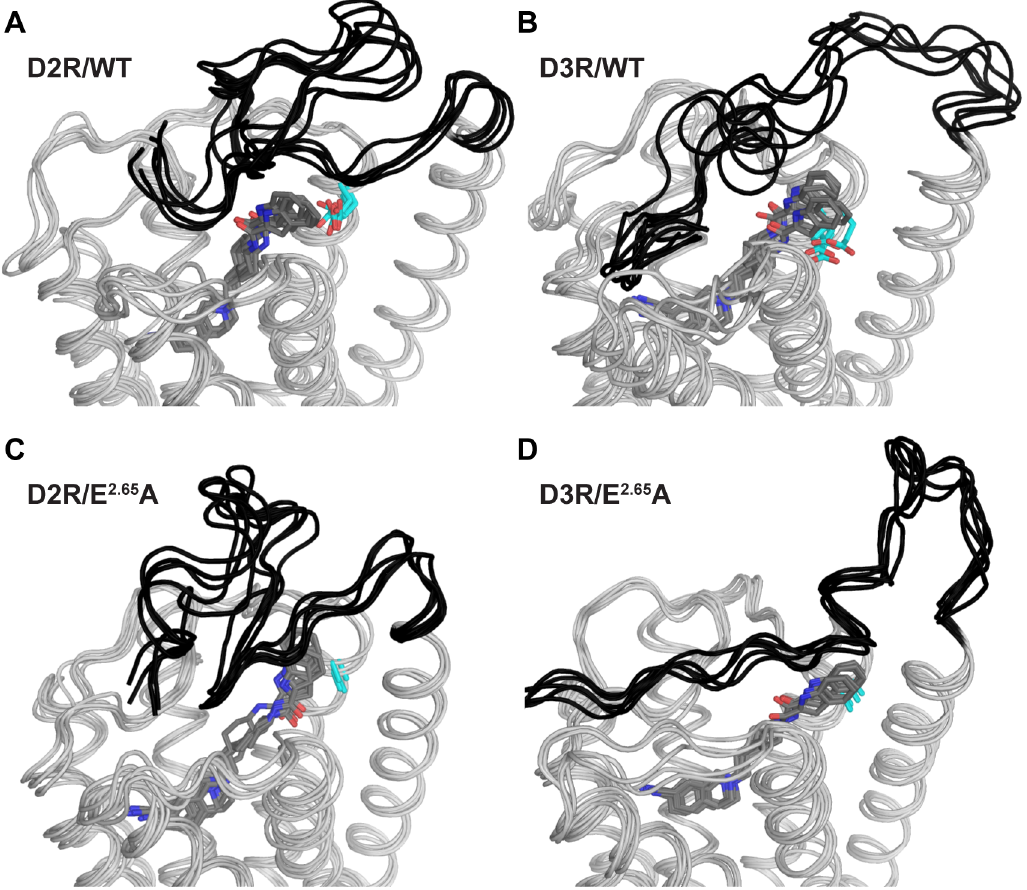
Fig 5. The E 2.65 A mutation affects the conformational dynamics of the NT. For each indicated condition, an ensemble of five representative frames of the largest NT cluster for each condition is shown. The N-terminal region is shown in black, and the bound SB269652 is shown as grey sticks (with nitrogen and oxygen atoms colored in blue and red respectively), whereas the residues at the 2.65 position are shown in cyan sticks. Molecular graphics was generated using PyMOL (version 1.7.6.5, Schro¨dinger,